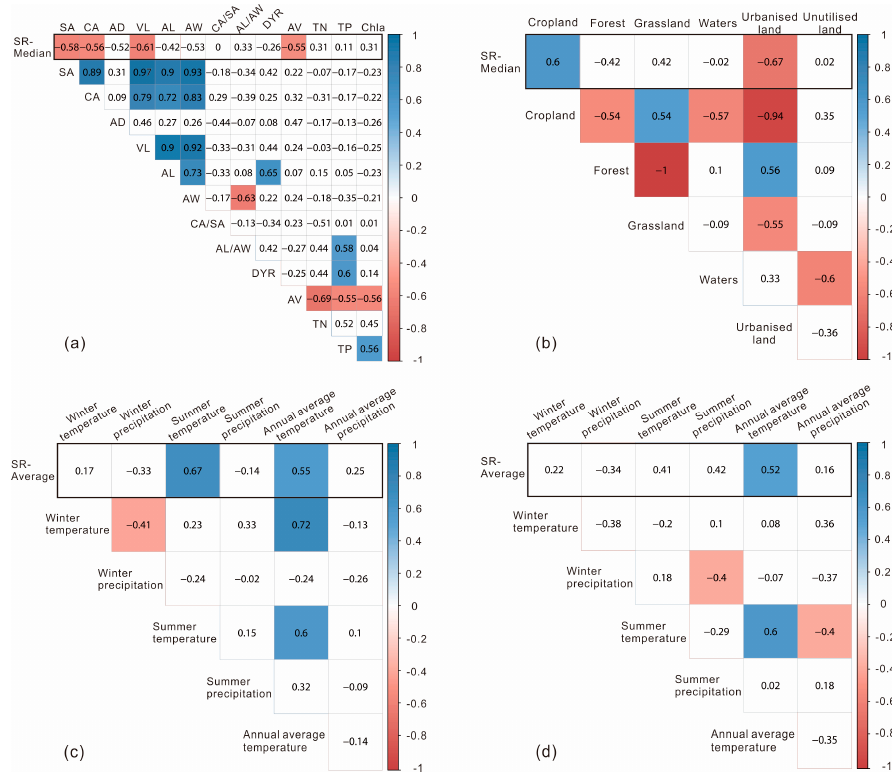
Figure 4. Results of correlation analysis: ( a ) SR-Median vs. lake features in recent 20 years; ( b ) SR-Median vs. Land use change in recent 20 years; and ( c , d ) (five-year average) SR-Average vs. climate change (winter, summer and annual temperature and precipitation) in Chaohu and Longgan Lake since 1850 respectively. The shaded bar represents the correlation coefficient, and each grid with colored background shows significance at 0.95. SA, surface area; CA, catchment area; AD, average depth; VL, water volume; AL, average length; AW, average width; CA/SA, surface area/catchment area; AL/AW, average length/average width; DYR, distance to the Yangtze River; AV, abundance of aquatic vegetation; TN, total nitrogen; TP, total phosphorus; and Chl-a, chlorophyll-a. Table 2. The extent of land use change (%) (six types) in the 14 lakes from the 1980s to the 1990s based on ArcGIS analysis.